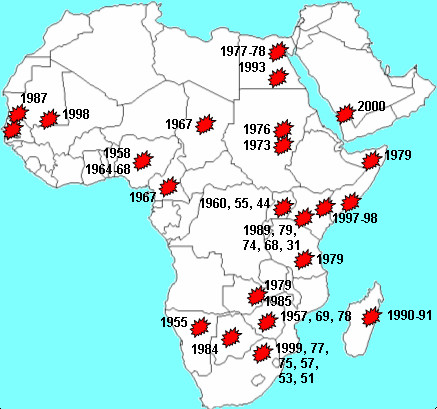
Locations of Rift Valley fever epidemics since the beginning of the 20th century.